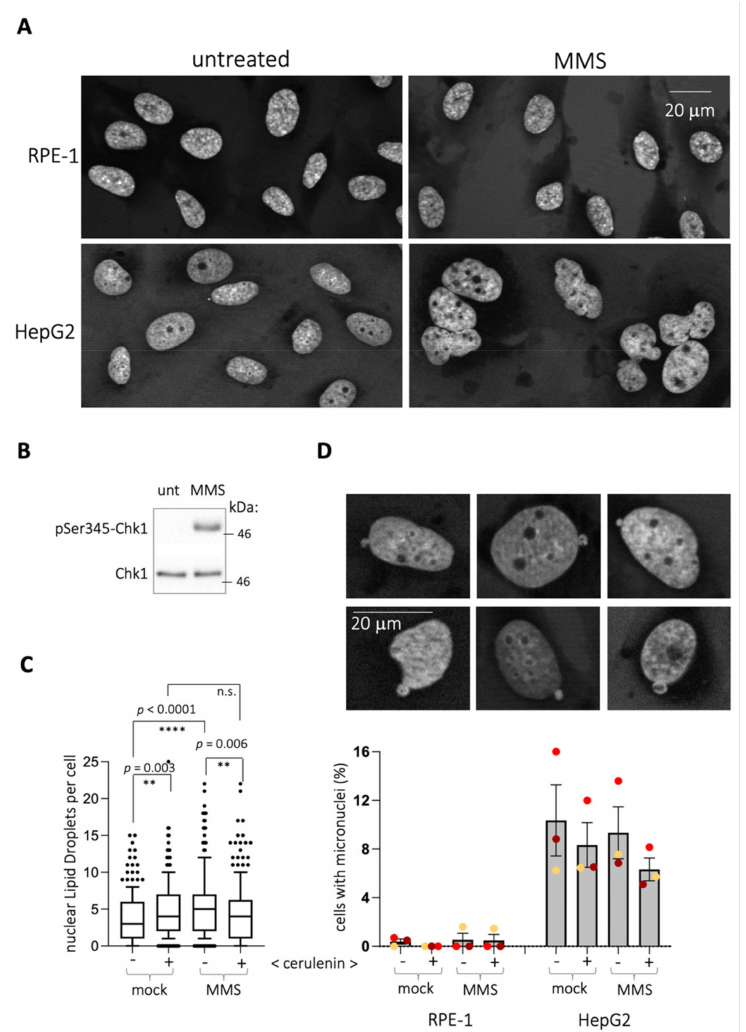
Figure 2. MMS triggers nuclear membrane alterations in HepG2 cells. ( A ) DAPI-stained nuclei of the indicated cell lines untreated or treated with 0.005% MMS for 2 h are shown to illustrate that MMS treatment in HepG2 triggers a general deformation of the nuclear perimeter. ( B ) Western blot of extracts from HepG2 cells untreated or treated with 0.005% MMS for 2 h to monitor the activation of the DDR by following the phosphorylation on serine 345 (pSer345) of the effector Chk1. Co-run molecular weight is indicated in kDa. ( C ) Quantification of the number of nLD counted in HepG2 cells upon treatment with the indicated agents. When cerulenin is indicated, it was added at 5 µ g/mL to the cultures for 4 h, plus 0.005% MMS or not for the last 2 h. Each dot corresponds to the value noted for one nucleus. At least 200 nuclei per experiment and condition were counted from 3 independent experiments. The boxes comprise the 10–90 percentile values, and their central bar represents the median of the population. Since the populations were not normally distributed, the significance of differences between the populations is indicated by by asterisks (*) and their associated p -values, obtained after applying a Mann–Whitney nonparametric test. n.s. stands for “not significant”. ( D ) Upper panel: illustrative pictures of HepG2 DAPI-stained nuclei displaying blebbing of the DNA material toward the cytoplasm, the initiating events of micronuclei during interphase. Lower panel: quantification of the percentage of cells in the population displaying blebbing and/or close- to-the-nucleus micronuclei in the indicated cell types after the indicated treatments. Each colored dot corresponds to an independent experiment. At least 150 cells were counted per experiment and condition. Within a same cell line, none of the treatments led to any significant difference with respect to the other ones after applying a Mann–Whitney nonparametric